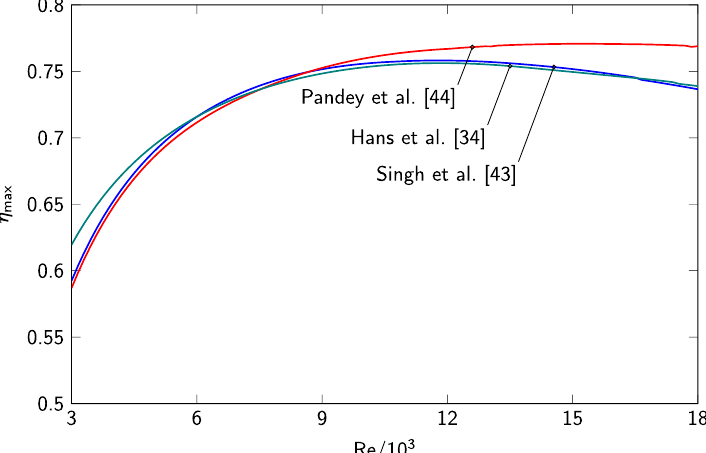
Figure 11. Relationship between η max and Re for absorber plates with curved ribs and ˙ G = 1000Wm − 2